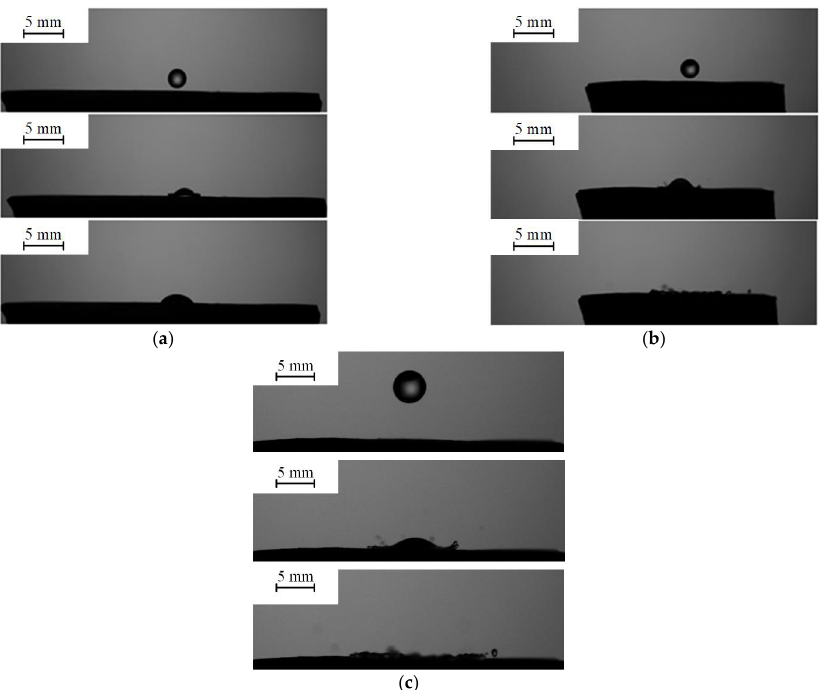
Figure 14. Images of collisions of distilled water droplets with substrates in the form of monolithic anthracite fragments at varying droplet impact velocities, R d = 1.1 mm: ( a ) — droplet at U d = 0.9 m/s (We = 30); ( b ) — droplet at U d = 2.6 m/s (We = 200); ( c ) — droplet at U d = 3.3 m/s (We = 300).